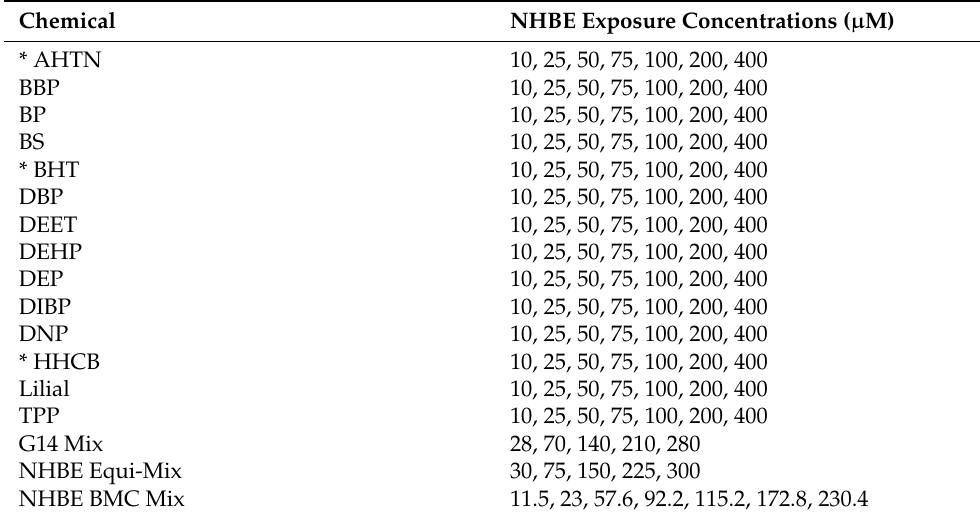
Table 3. Nominal concentrations used for NHBE bioactivity screening.